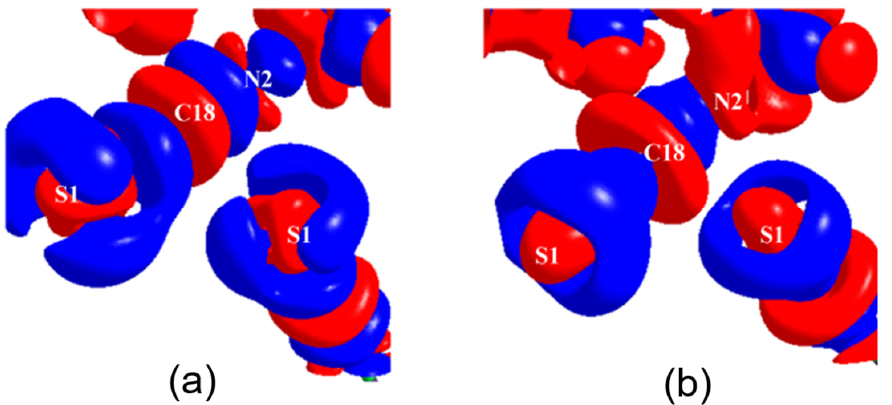
Figure 19. The 3D deformation density plots ( a ) experimental and ( b ) theoretical charge density analysis highlighting the N=C=S ··· N=C=S interaction motif. Blue and red: +ve and –ve electron density, respectively. The deformation density contours are drawn at − 0.05 eÅ − 3 . (Figure reproduced from reference [90] ).